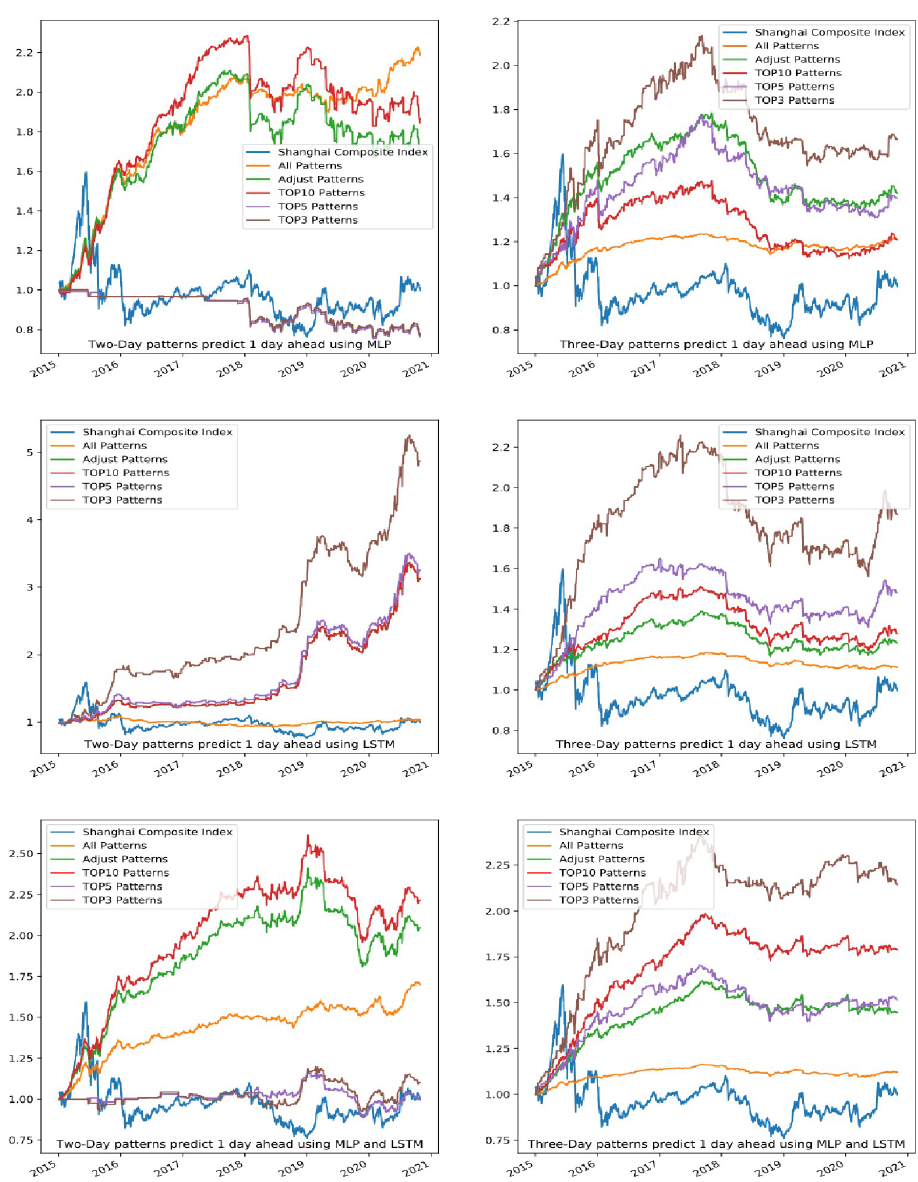
Fig 10. One day ahead forecasting performance of MLP and